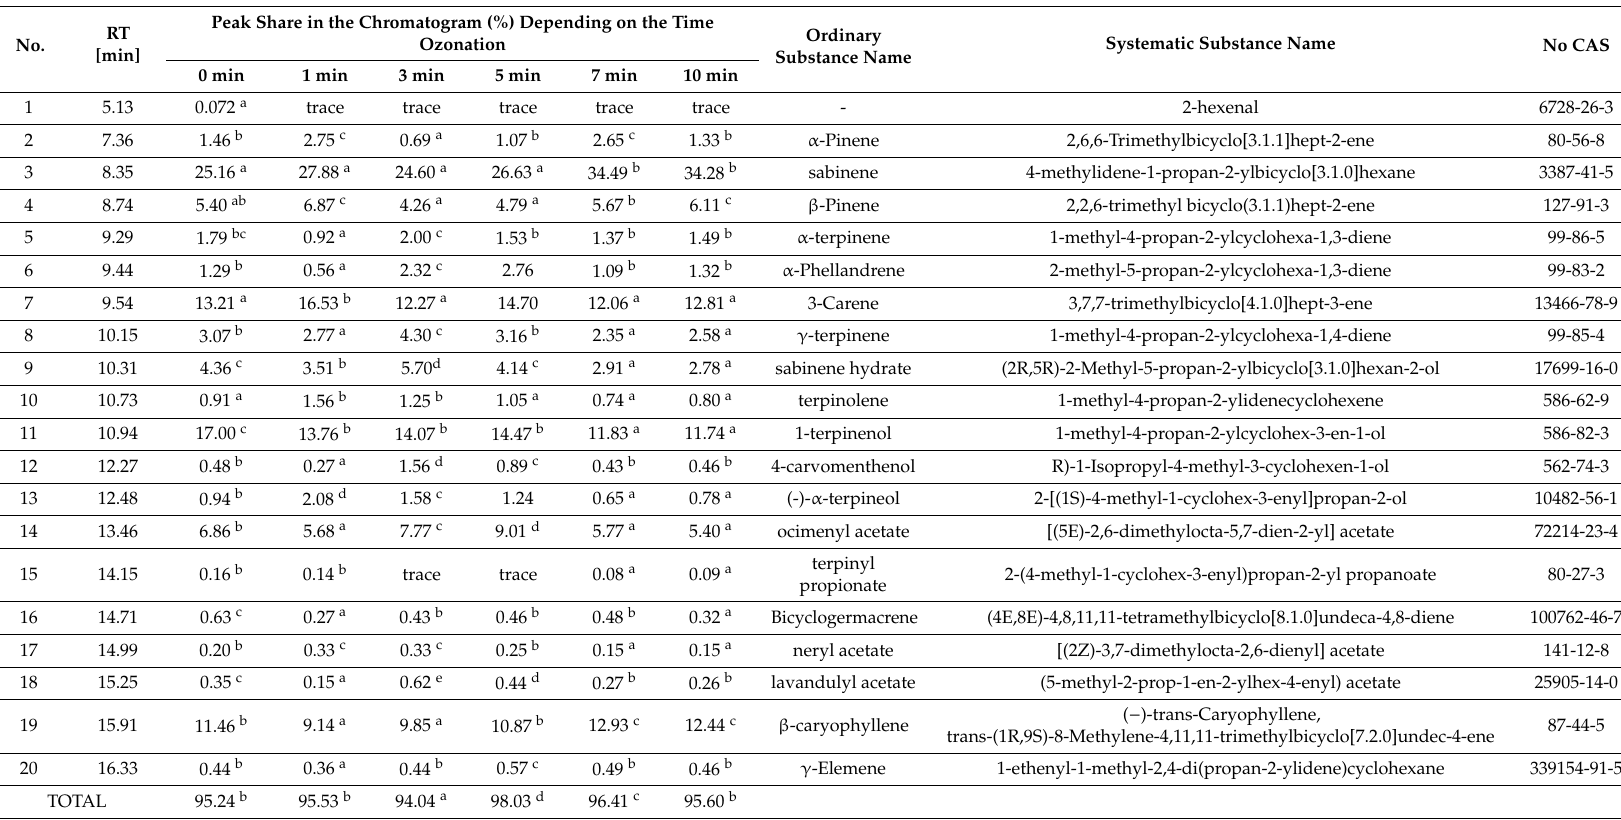
Table 1. Chemical composition of headspace fractions of Origanum majorana L. leaves depending on the time ozonation in one day from ozonation (n = 3).